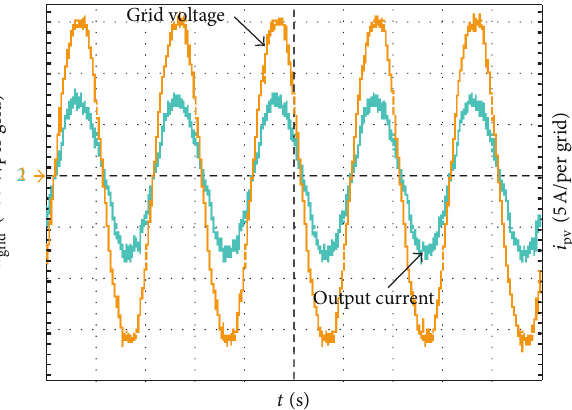
Figure 11: The experimental results in grid-connected